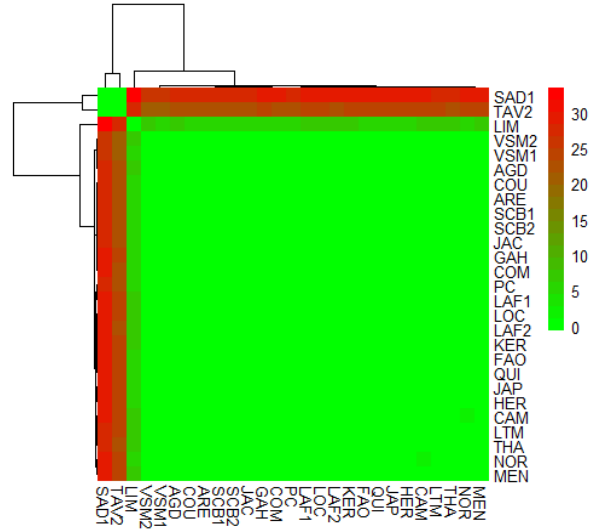
Figure 4. Pairwise F ST matrix (displayed in percentage) in the large scale Dataset 3.